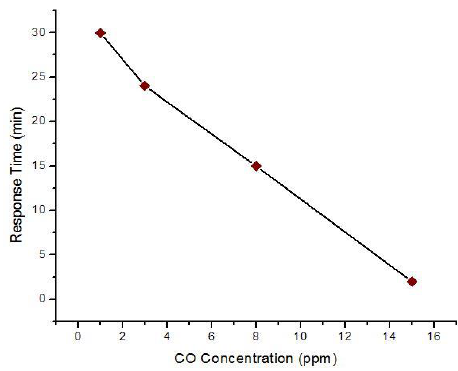
Figure 15. Response time of TiO 2 (calcination temperature 600 °C) to 1 – 15 ppm CO gas at 200 °C.